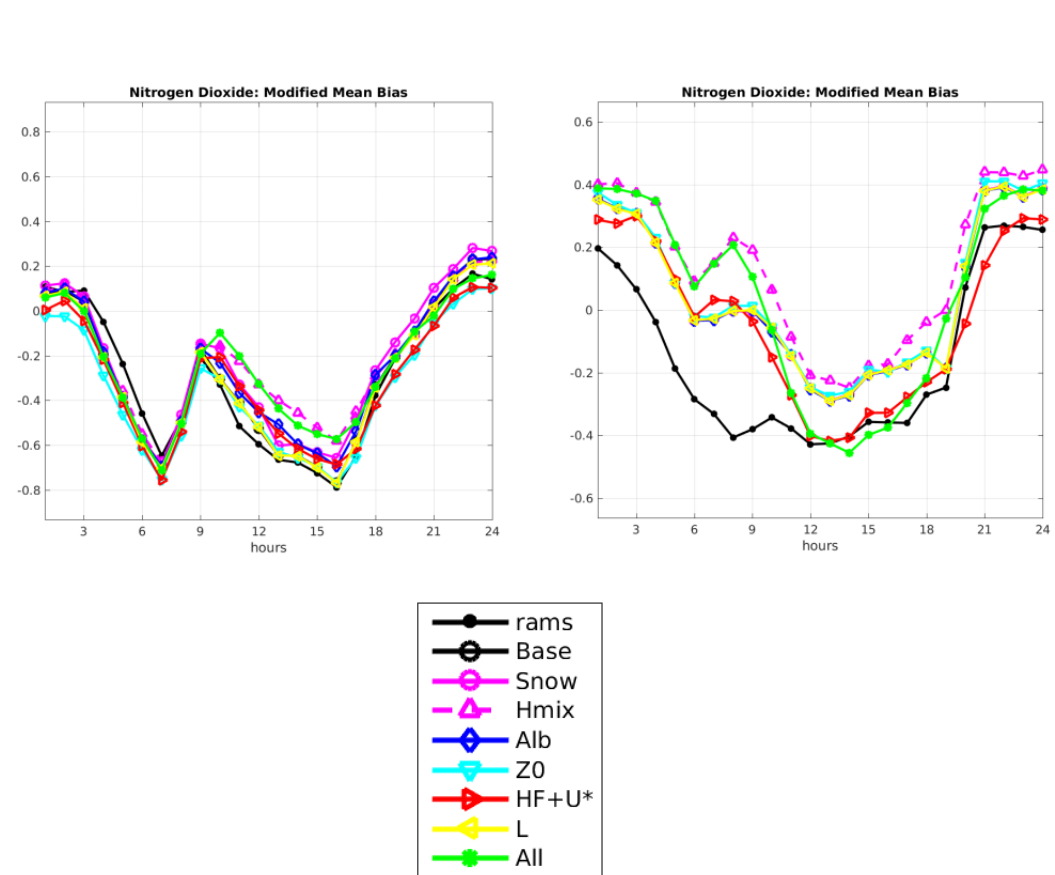
Figure 6. NO 2 —R of hourly concentrations (upper panel), MMB of hourly concentrations (lower panel), for January (left) and August (right). The x ‐ axis reports UTC times.